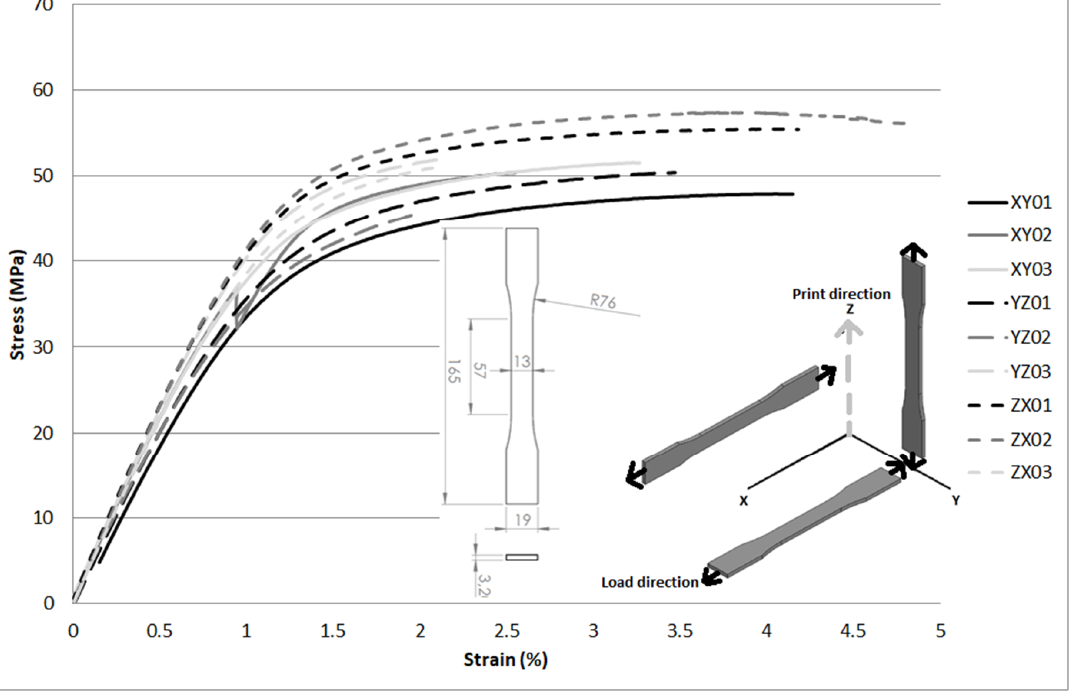
Table 4. Values obtained from tensile tests and reference values from Russian GOST normative 10589- 63 [32] for PA and 9639-61 [33] for PVC-U.